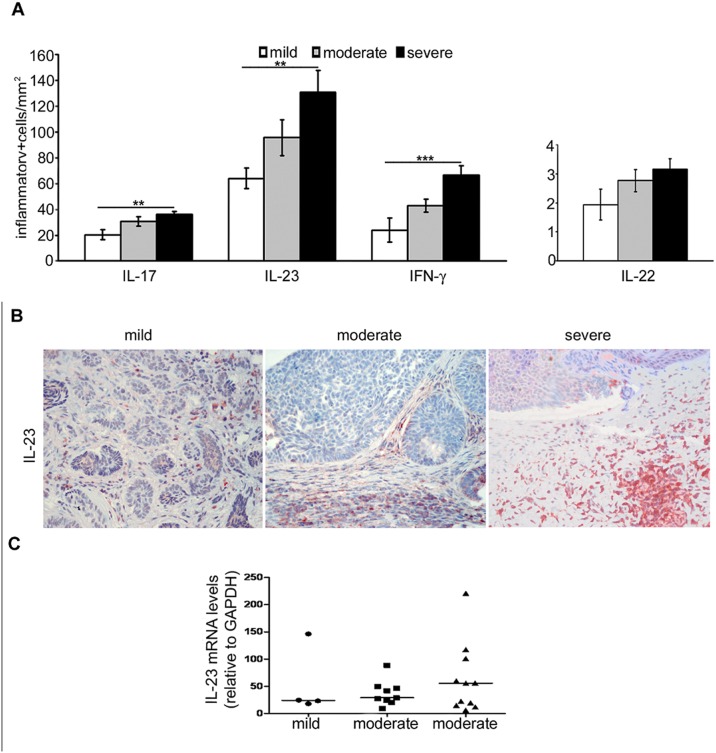
Immunohistochemical and mRNA expression of IL-17, IL-23, IFN-γ and IL-22 varies according to severity of the inflammatory infiltrate in BCC.(A) Graph showing cytokine levels in BCC, considering the severity of the inflammatory infiltrate. Statistically significant higher levels of IL-17, IL-23 and IFN-γ expression were observed with the increasing amount of peritumoral inflammatory infiltrate and the trend was similar for IL-22 expression. **p<0.01; ***p<0.001; (B) Exemplificative images of increasing IL-23 immunostaining in BCC samples associated to absent/mild, moderate and severe inflammation; (C) Variation of IL-23 mRNA expression levels according to the amount of the peritumoral inflammatory infiltrate.